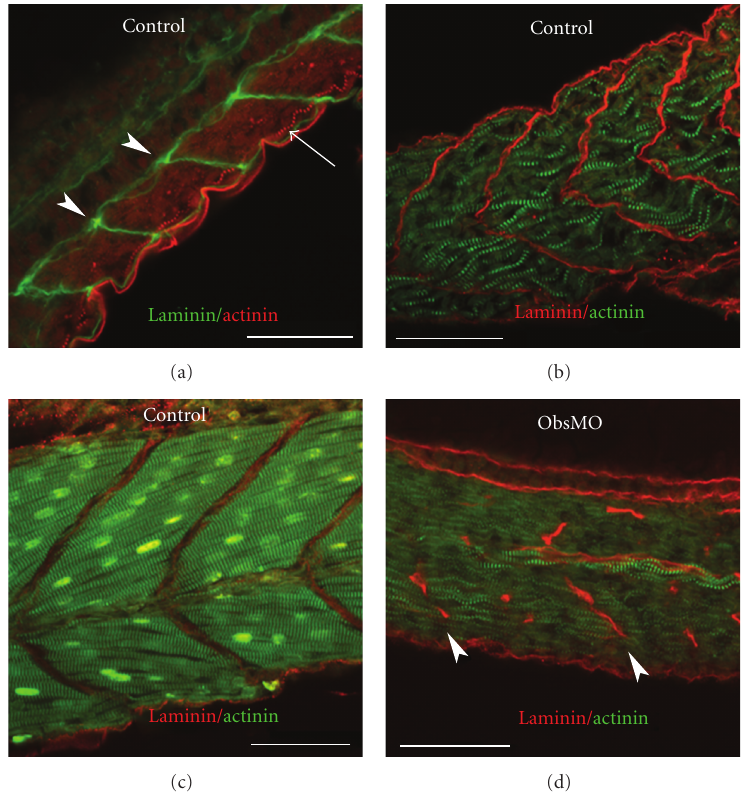
Figure 5: Laminin deposition precedes but is not a requirement for fast-twitch skeletal muscle myofibrillogenesis. Zebrafish embryos were immunolabeled for laminin ((a): green; (b), (c), (d): red) and α -actinin ((a): red; (b), (c), (d): green) at 20 (a), 24 (b), (d), and 48 (c) hpf. (a) A mature laminin matrix has formed at the somite/myotome boundaries (arrowheads) and along the surface of the myotome prior to fast-twitch skeletal muscle myofibrillogenesis. By this time, slow-twitch skeletal muscle has migrated to its superficial location within the myotome (arrow). As fast-twitch skeletal muscle myofibrillogenesis progresses, laminin persists at the somite boundary at 24 (b) and 48 (c) hpf. In response to obscurin A depletion (d), laminin accumulates normally at the irregularly localized and incomplete MTJs (arrowheads). Fast-twitch skeletal muscle myofibrillogenesis is delayed in the regions lacking laminin deposition but does eventually proceed. Scale bars are 50 μ m (a), (b), (d) and 30 μ m